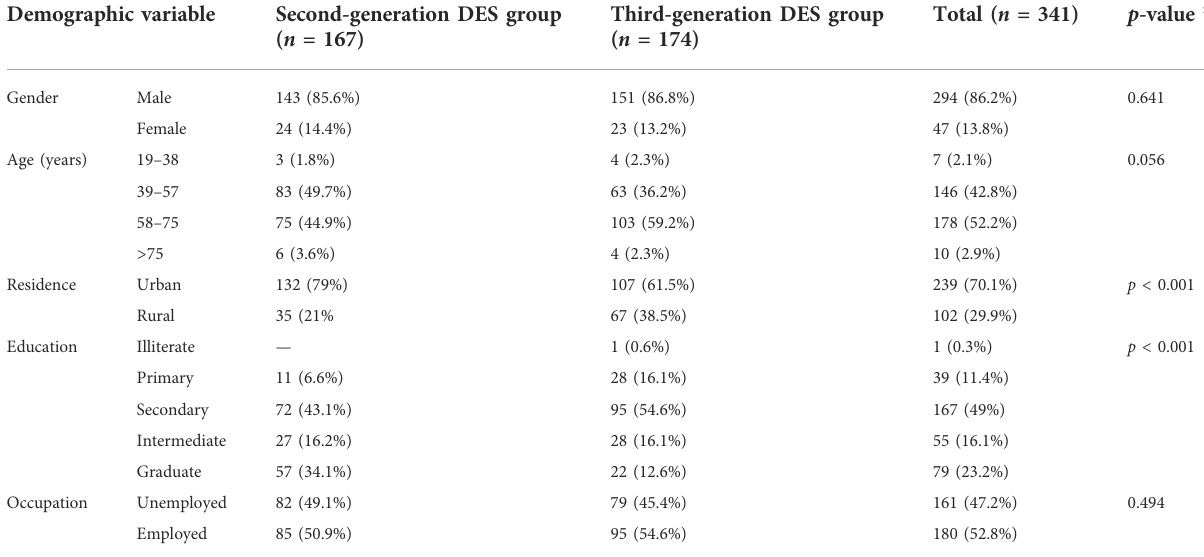
TABLE 1 Demographic characteristics of the study participants.